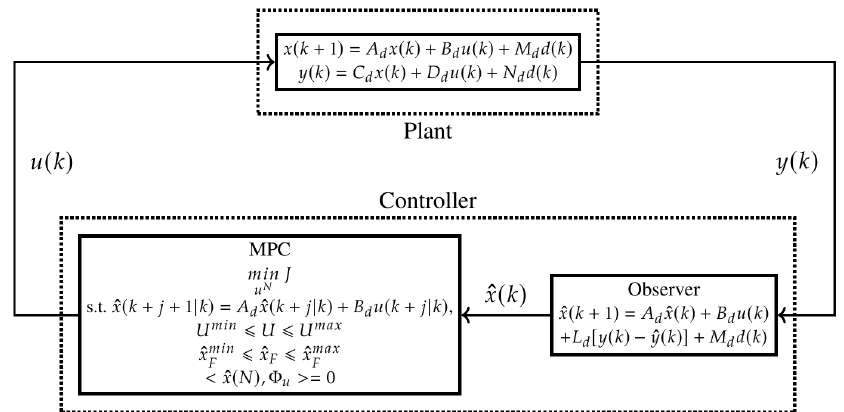
Figure 5. Representation of the closed